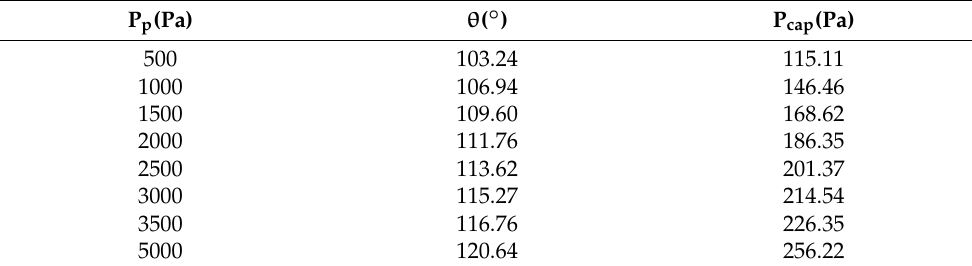
Table 2. Contact angle and capillary pressure at each pump pressure applied for healthy blood